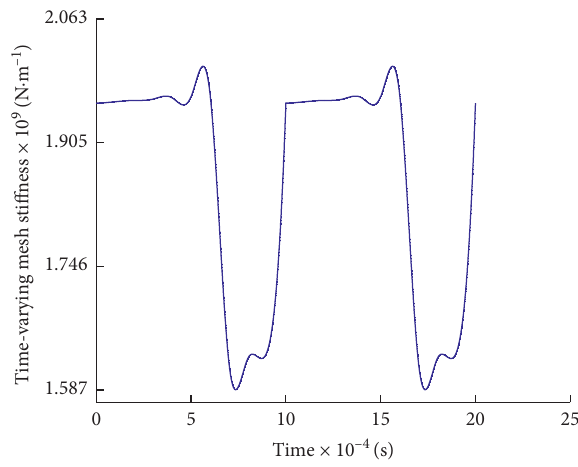
Figure 3: Time-varying mesh stiffness